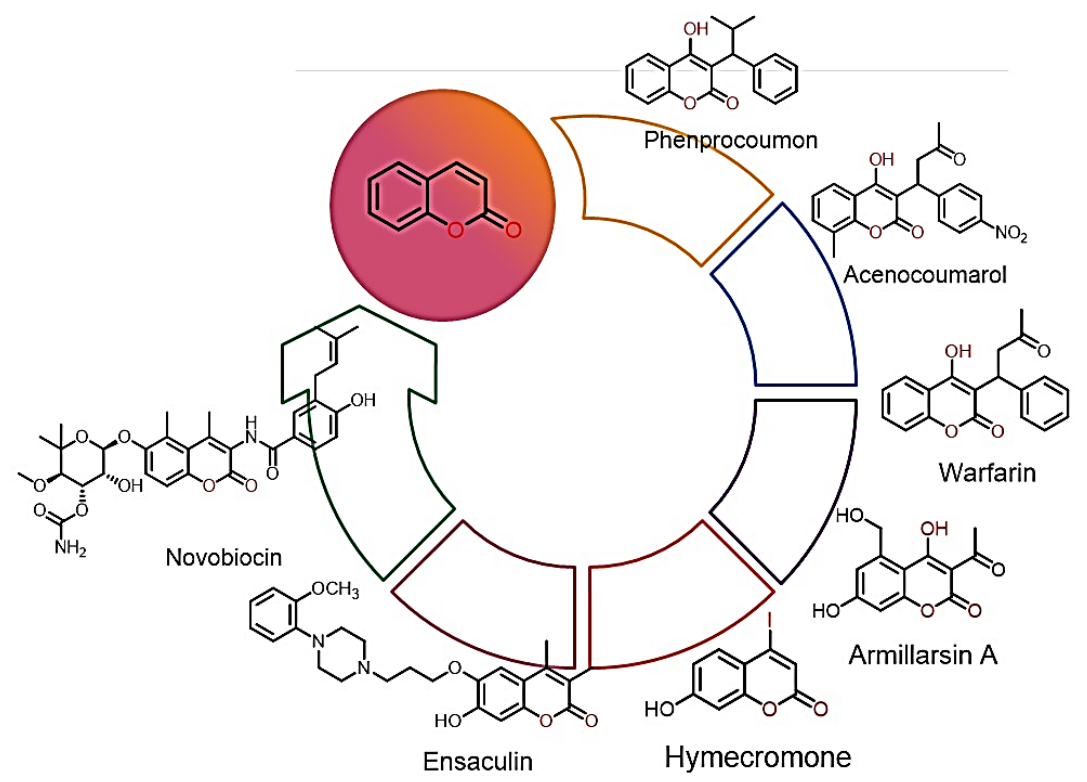
Figure 1. Pharmacological spectrum of coumarins.